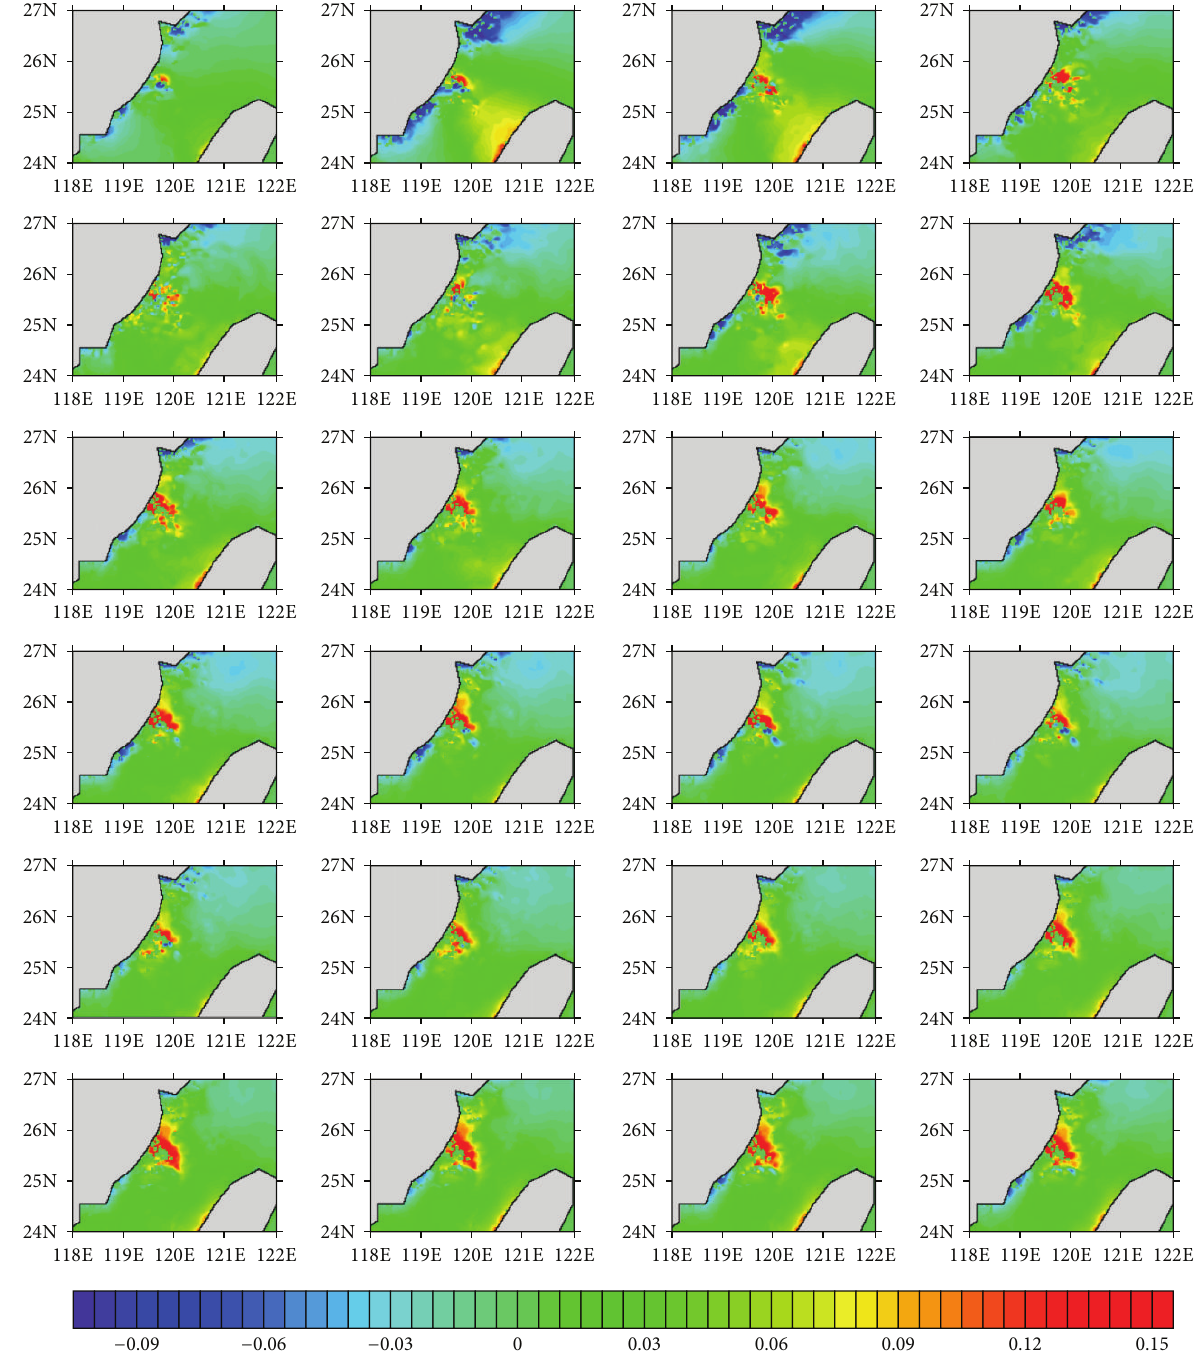
Figure 4: Sea level differences between Experiments 1 and 2. (Units: m; from left to right and from top to bottom, the plot, resp., presents the situation of 1, 2, 3, ... ,24